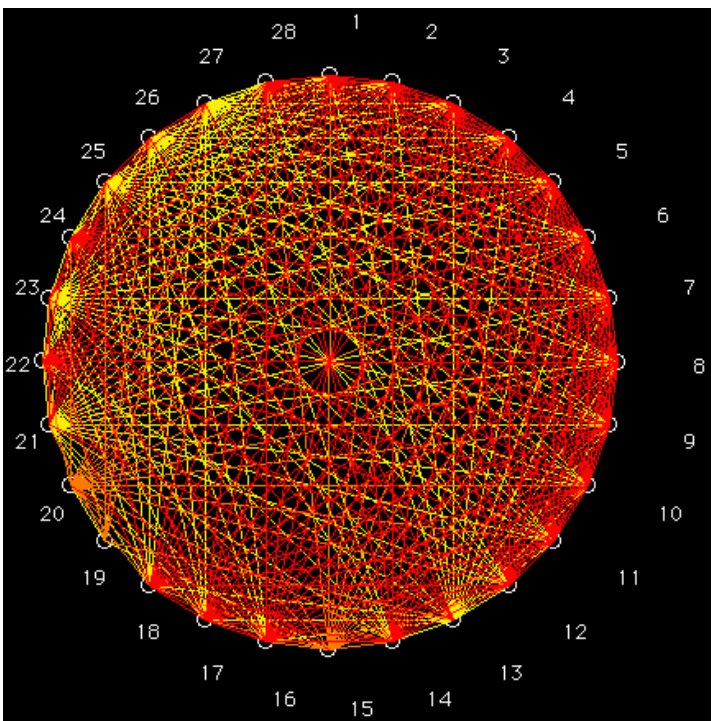
Figure 2. Partial correlation diagram: high (red), medium (orange) and low (yellow) correlations.